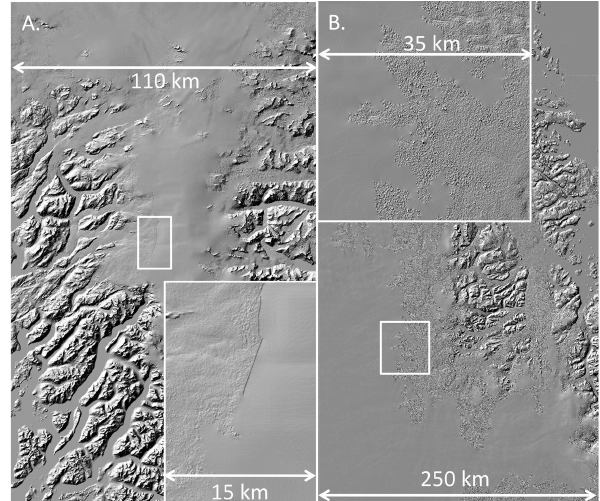
Figure 9. Hillshade representation of the GIMP DEM for the termi- nus of Kangerdlugssuaq glacier, East Greenland (tile 4,2) showing artifacts created by rapid elevation change. In this case, ice thin- ning of ∼ 100m over the data collection period results in spurious, ∼ 10m tall rises in the surface visible here as large bumps in the center of the glacier and clustered around its margins. Also visi- ble is a region of dense icebergs, also known as mélange, at the glacier front in the bottom right corner. This mélange region was not masked due to retreat of the glacier between the time the ice front was mapped and the elevation data were